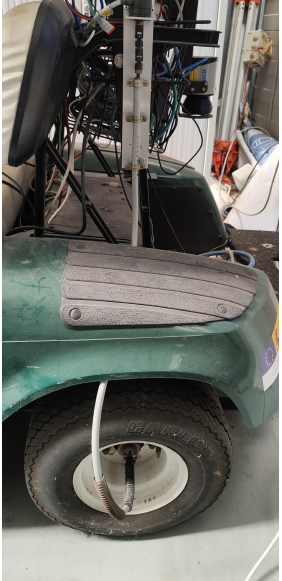
Figure 2. The odometric sensor coupled to the rear